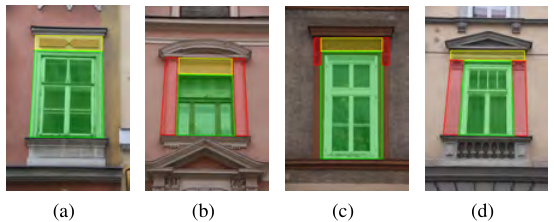
Figure 4: Pilasters, brackets, friezes and architraves, and their possible arrangements. A window with no side decoration but with a frieze (yellow) is shown in (a). Pilasters (red) bypass the frieze in (b). Pilasters can be reduced to smaller brackets that support the cornice (c). Finally, pilasters end at the top of the window opening and support an architrave